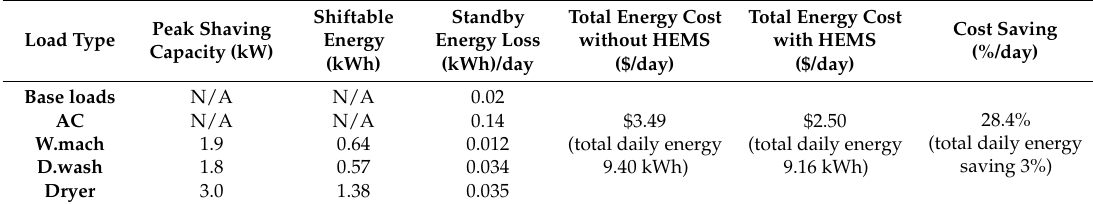
Table 3. Energy cost savings analysis.